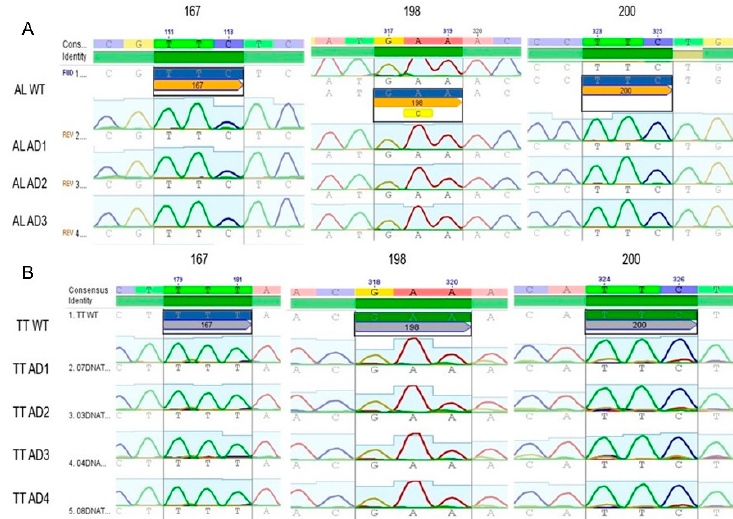
Figure 1. Electropherogram of sequences obtained from adult Trichuris trichiura and Ascaris lumbricoides specimens recovered from Honduran SAC and Pre-SAC. Subsection A illustrates three sequences (ALAD1, ALAD2, and ALAD3) from adult Ascaris specimens and subsection B shows 4 sequences (TTAD1, 2, 3, and 4) compared to a consensus sequence ( A. lumbricoides GenBank accession. number: FJ501301.1 and for T. trichiura , AF034219.1), the codons of interest are represented by their